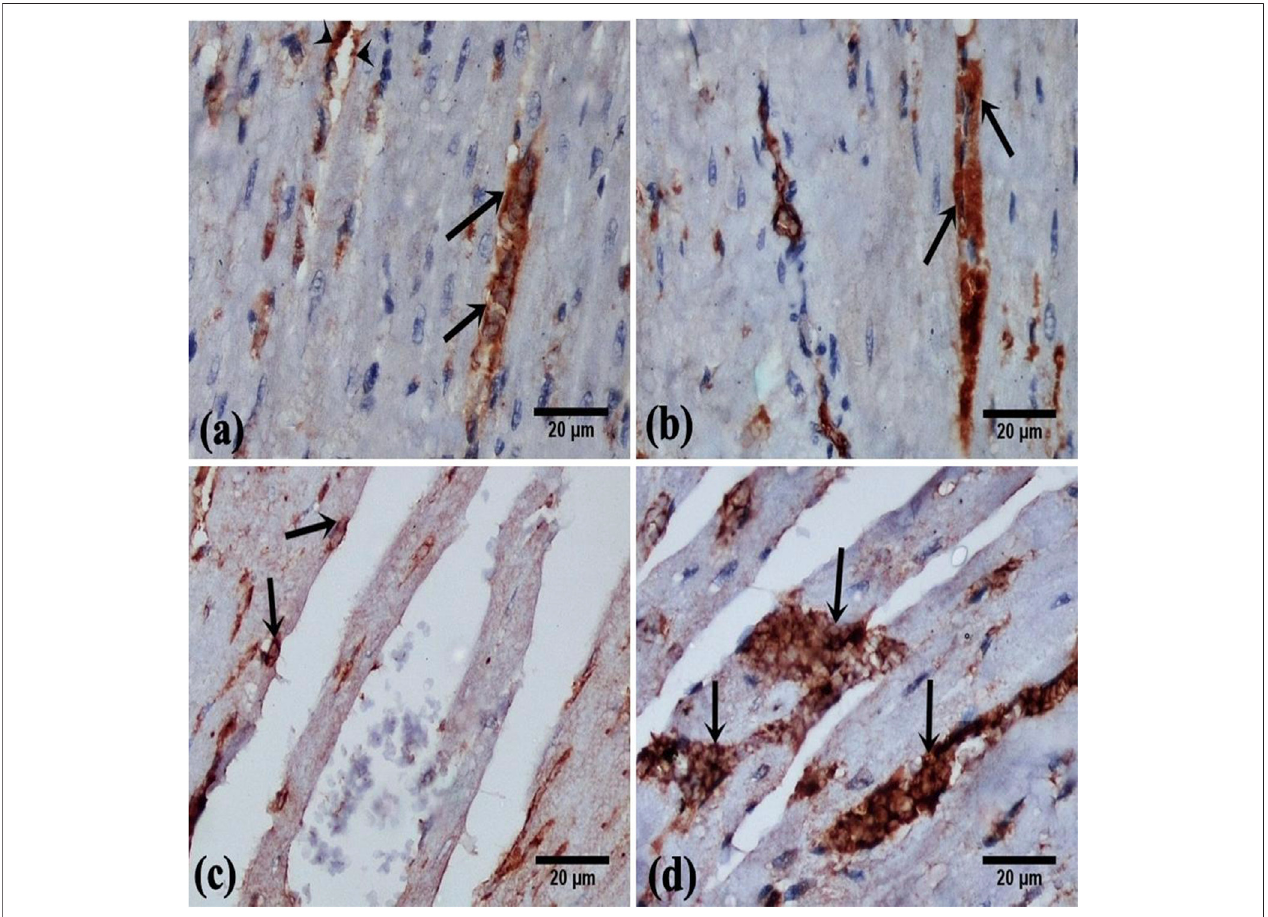
FIGURE 5| photomicrographs ofvimentin cytoplasmic immunoreaction in the rat myocardial sections, in cardiomyocytes (arrow) and in the endothelial cells of the bloodvessels(arrowhead) (A,B) Fromgroup(I)andgroup(II)respectivelyshowmoderateimmunoreaction. (C) Fromgroup(III)showingfaintimmunoreaction. (D) From group (IV) showing marked immunoreaction (vimentin immunostaining, X400).